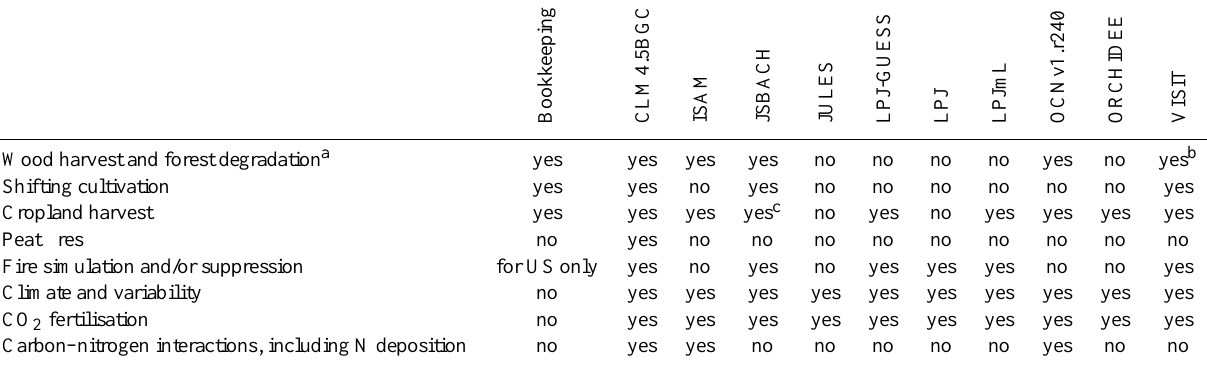
a Refers to the routine harvest of established managed forests rather than pools of harvested products. b Wood stems are harvested according to the land-use data. c Carbon from crop harvest is entirely transferred into the litter